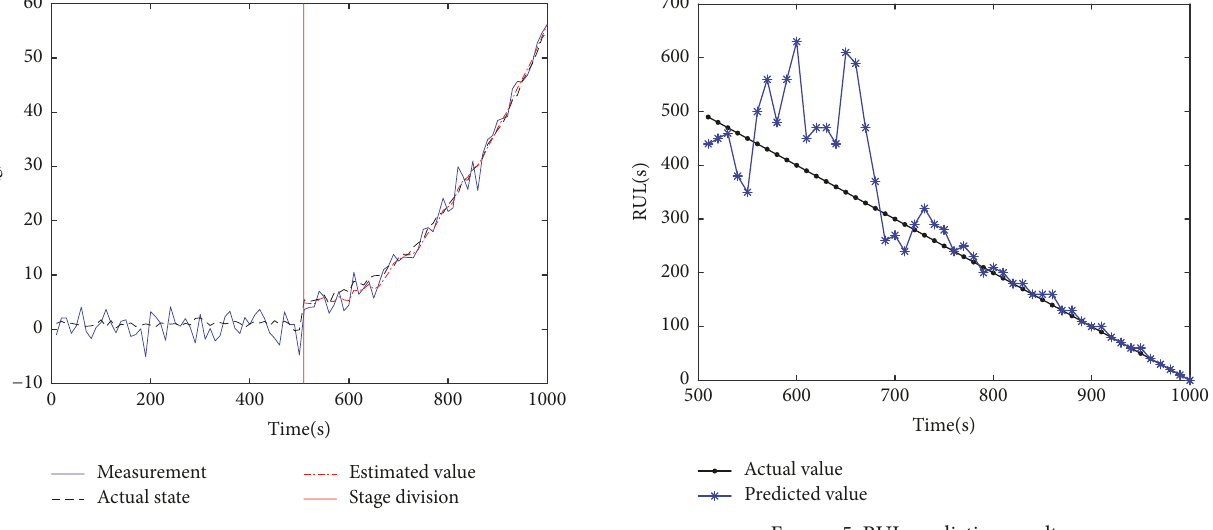
Figure 3: Simulated degradation path.